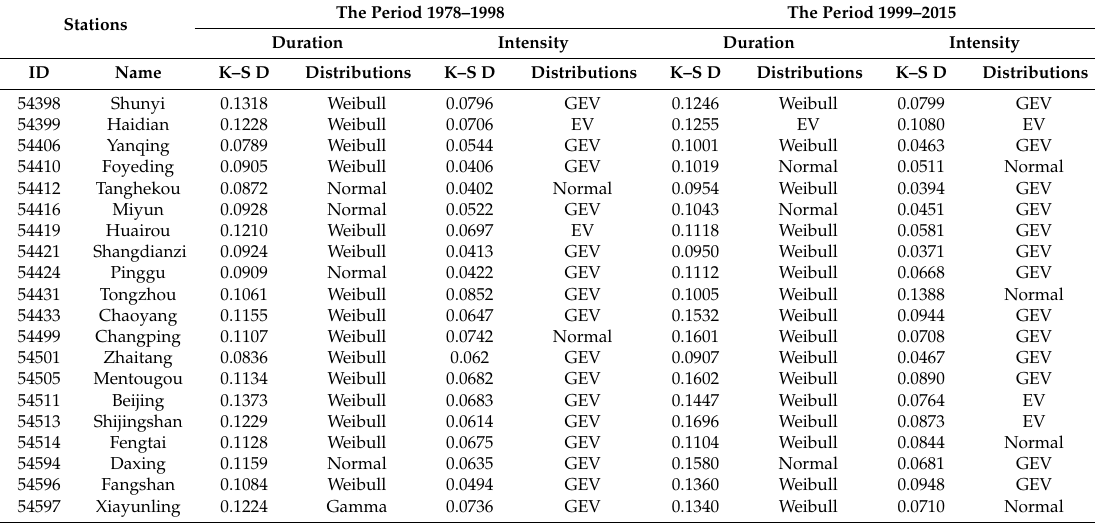
Table 4. The goodness-of-fit based on the Kolmogorov–Smirnov (K–S) D statistic for marginal distributions of duration and intensity for low temperature events at 20 meteorological stations in Beijing. EV—extreme value; GEV—generalized EV.